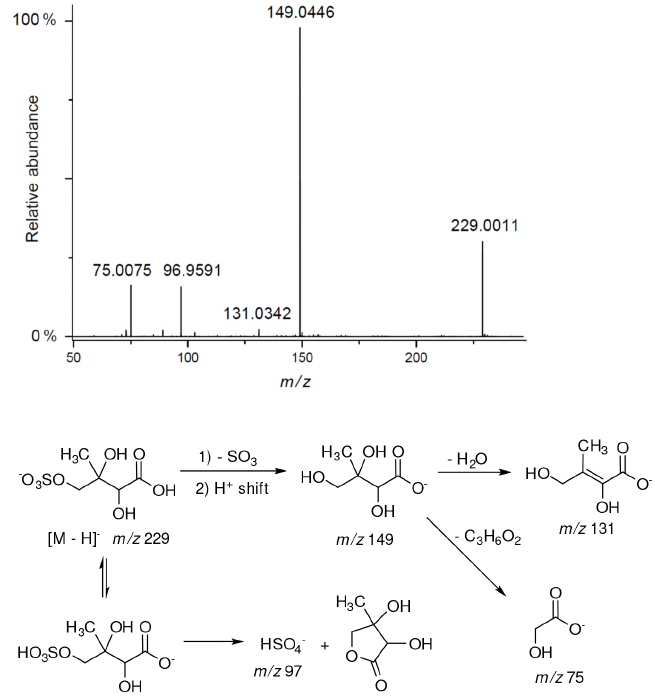
Figure 12. Electrospray product ion mass spectrum ( − ) of 2-methylthreonic acid organosulfate (MW 230) at RT = 0.63min (Fig. S4) acquired for Zielonka PM 2 . 5 aerosol along with the proposed fragmentation